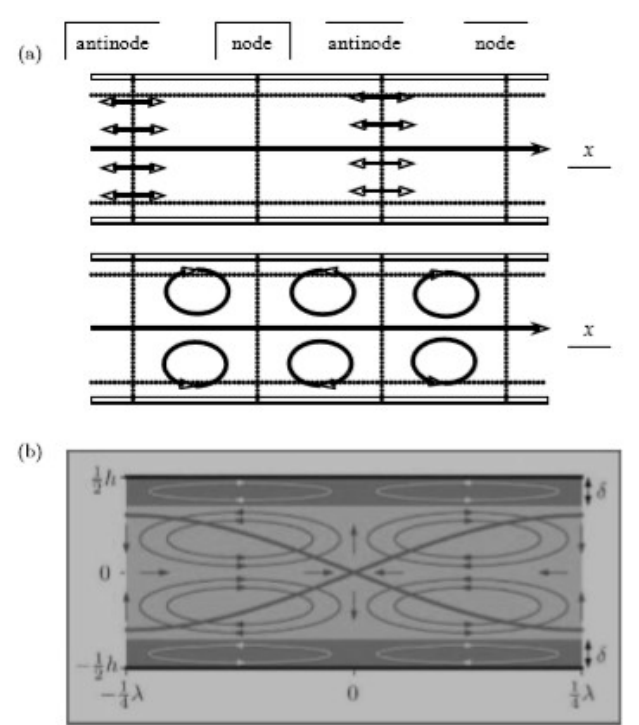
Figure 2. Two rigid planes separated by a distance H.